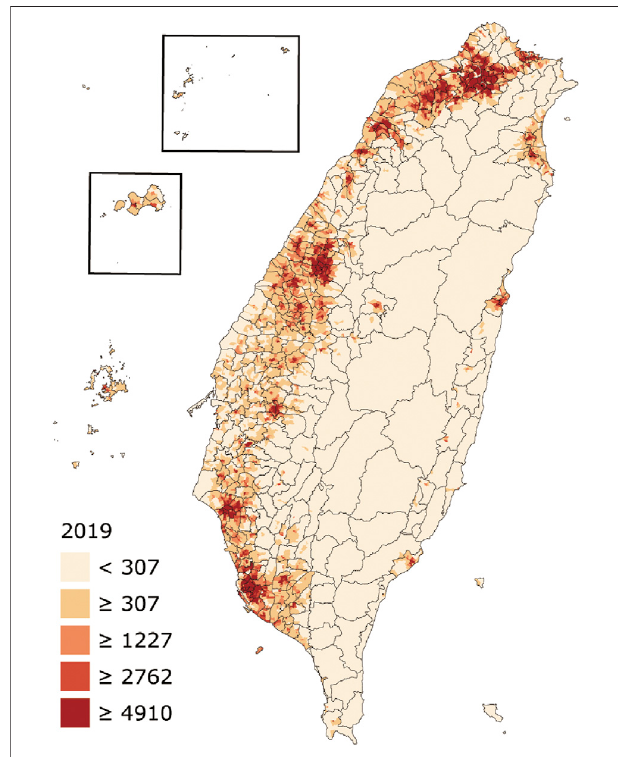
FIGURE 1 | Geographic map and population density of Taiwan. The numbers show residents per square kilometer by village (from: https://en.